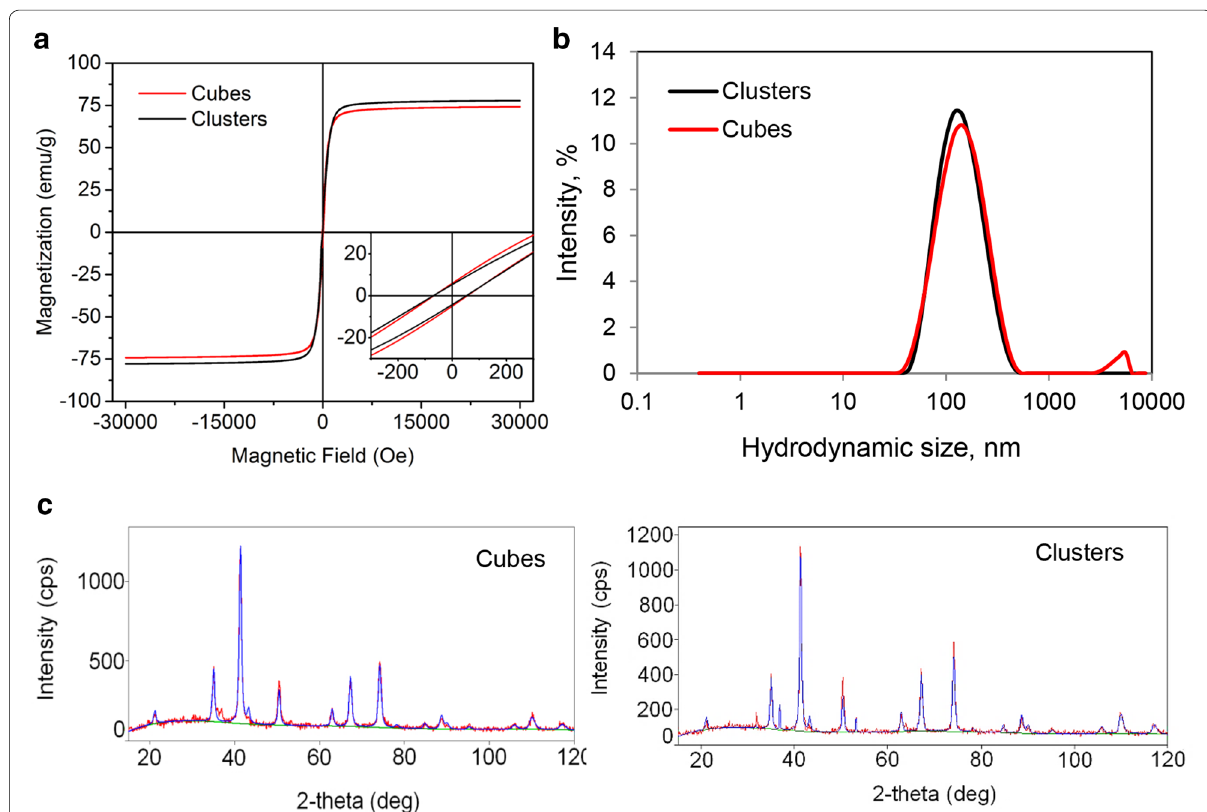
Fig. 2 Physicochemical characterization of the iron oxide nanocubes (IO-cubes) and nanoclusters (IO-clusters). a Room temperature magnetization curves of IO-cubes and IO-clusters using magnetic field range from 30 to 30 kOe. b Hydrodynamic diameters of IO-cubes and IO-clusters in PBS − after surface modification with PEG as measured by dynamic light scattering utilizing Zetasiser Nano ZS. c XRD patterns of IO-cubes and IO-clusters with the indexation of the Bragg peaks to an inverse spinel